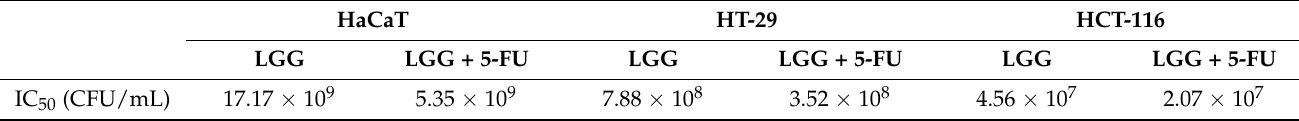
Table 1. The calculated IC 50